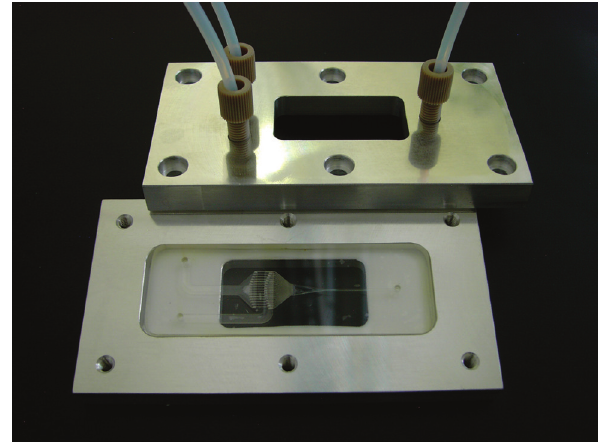
Figure 1 Interdigital mixer for